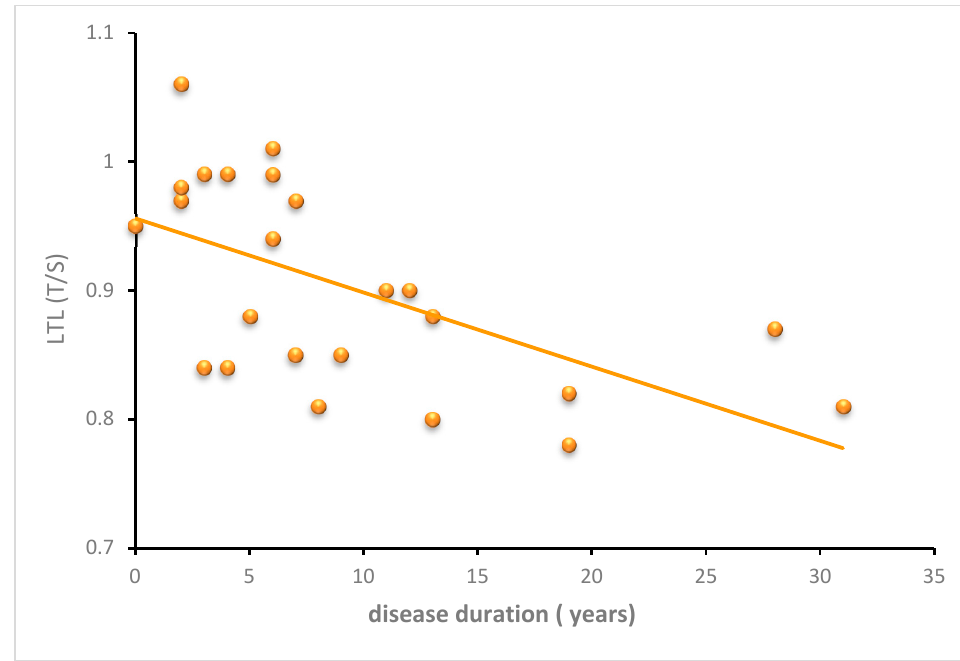
Figure 7. Relationship between LTL and SCA3 disease duration. Scatter plot showing the negative correlation between LTL and disease duration in SCA3 patients (y = − 0.0057x + 0.96, p = 0.003).